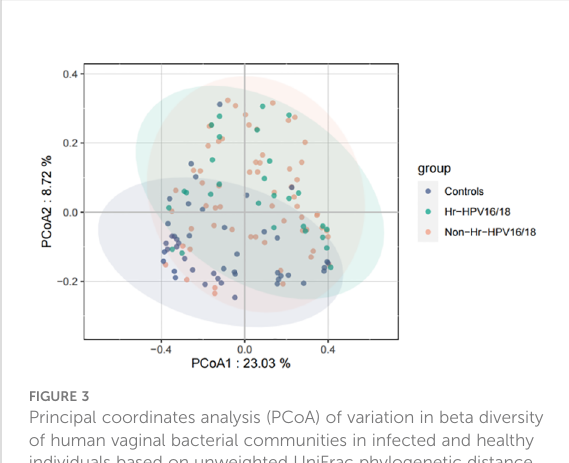
FIGURE 3 Principal coordinates analysis (PCoA) of variation in beta diversity of human vaginal bacterial communities in infected and healthy individuals based on unweighted UniFrac phylogenetic distance. Hr-HPV16/18 (n = 28): HPV16/18 high-risk infection group; Non- Hr-HPV16/18 (n = 62): non-HPV16/18 high-risk infection group; controls (n = 45): non-HPV infection group.